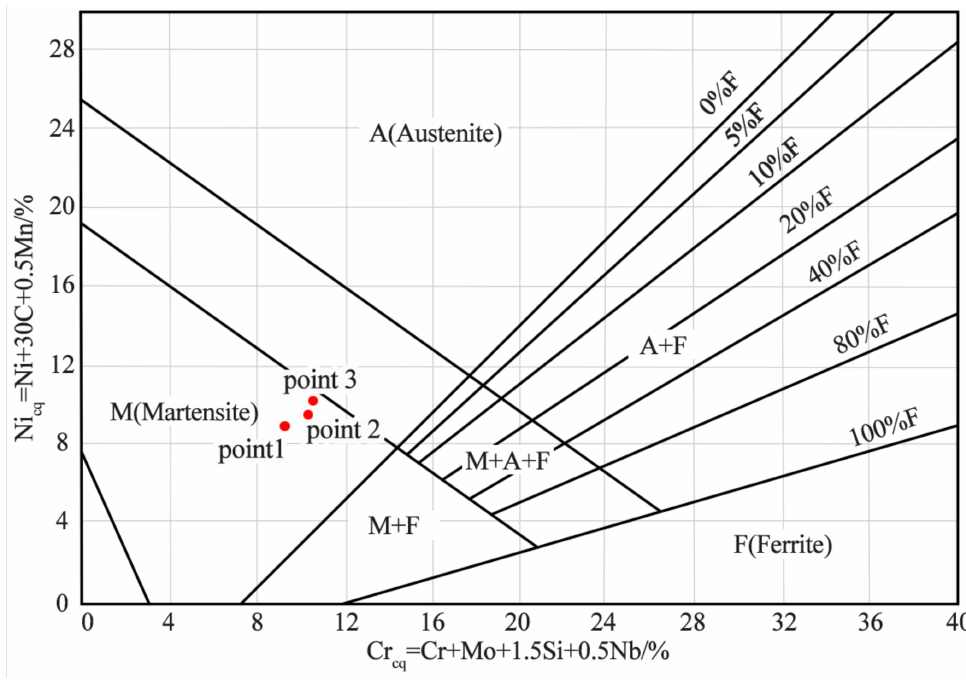
Figure 12. Schaeffler phase diagram. Table 4. Elemental compositions of the test points and corresponding Cr and Ni